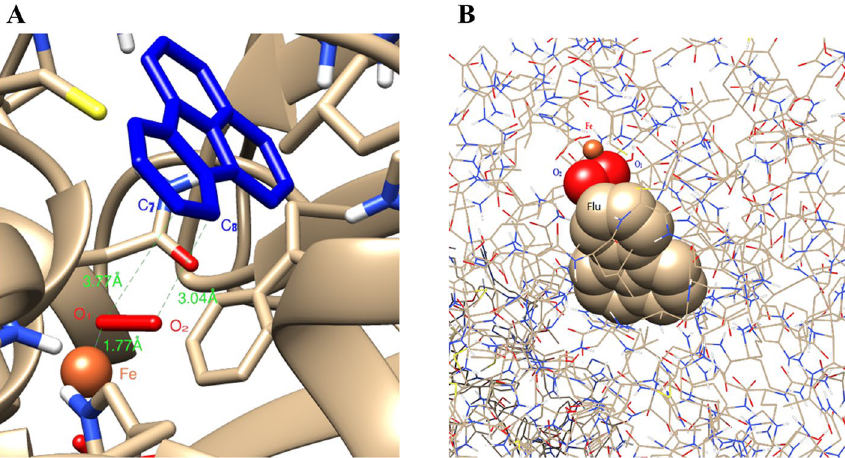
Figure 5. The detailed interaction between fluoranthene and the active site of alpha subunit ( A : the fluoranthene structure was shown in stick mode and colored blue , and the positions of C 7 and C 8 atoms on the fluoranthene ring were the best oxidation sites in the active activity. B : the oxygen atoms, iron atom and fluoranthene were shown in ball mode).